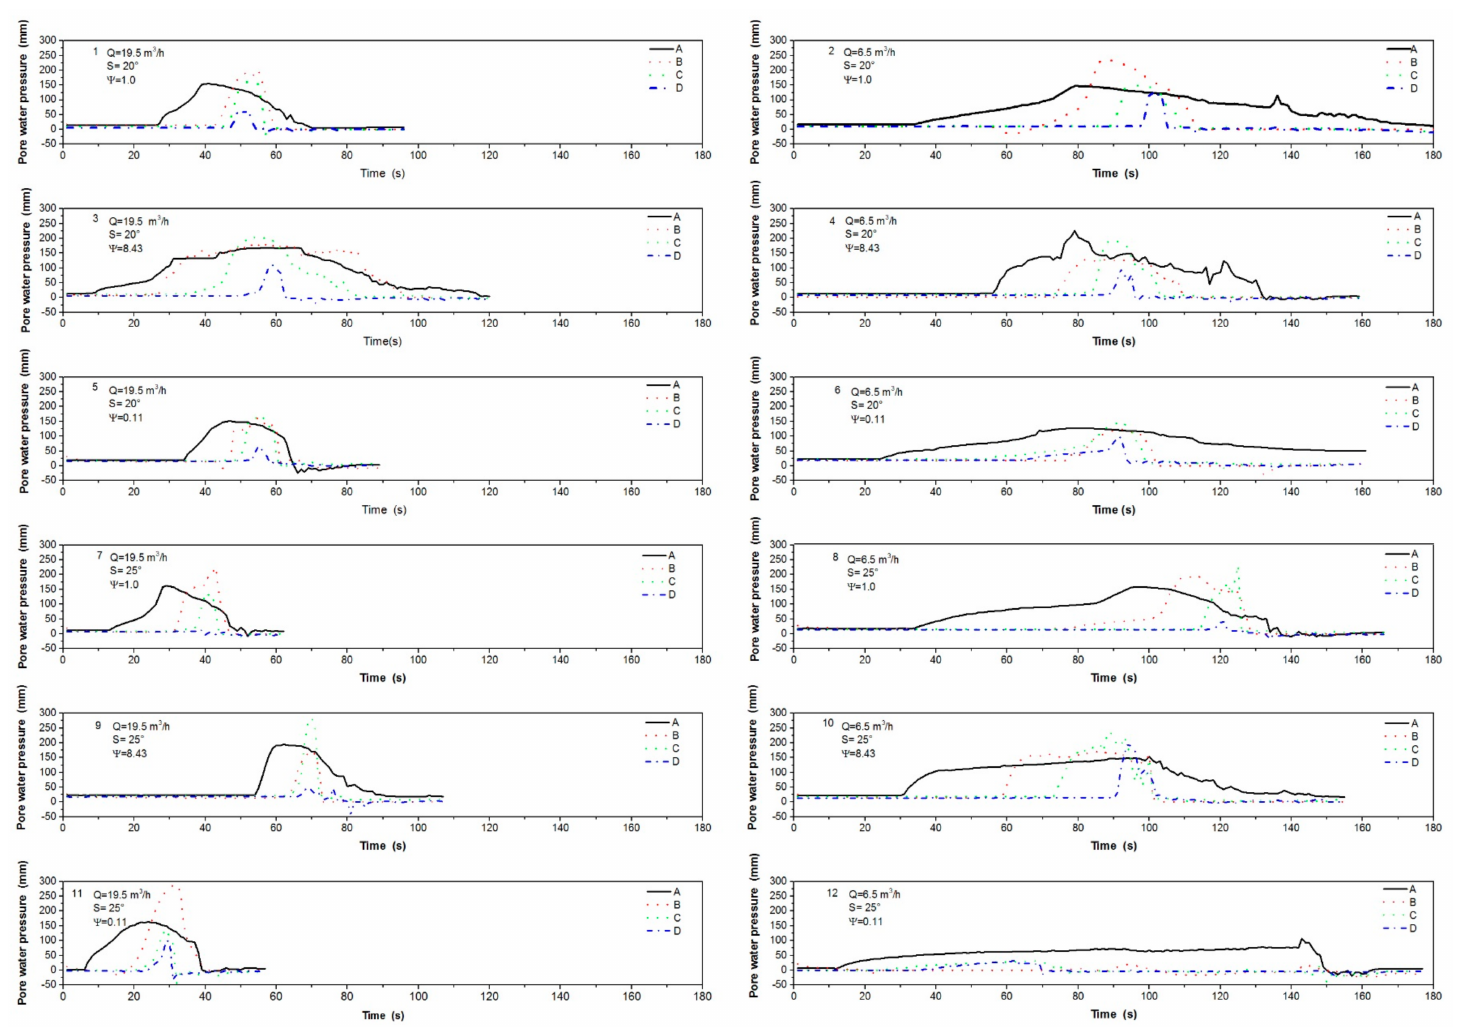
Figure 4. The variation curve of pore water pressure in each experiment